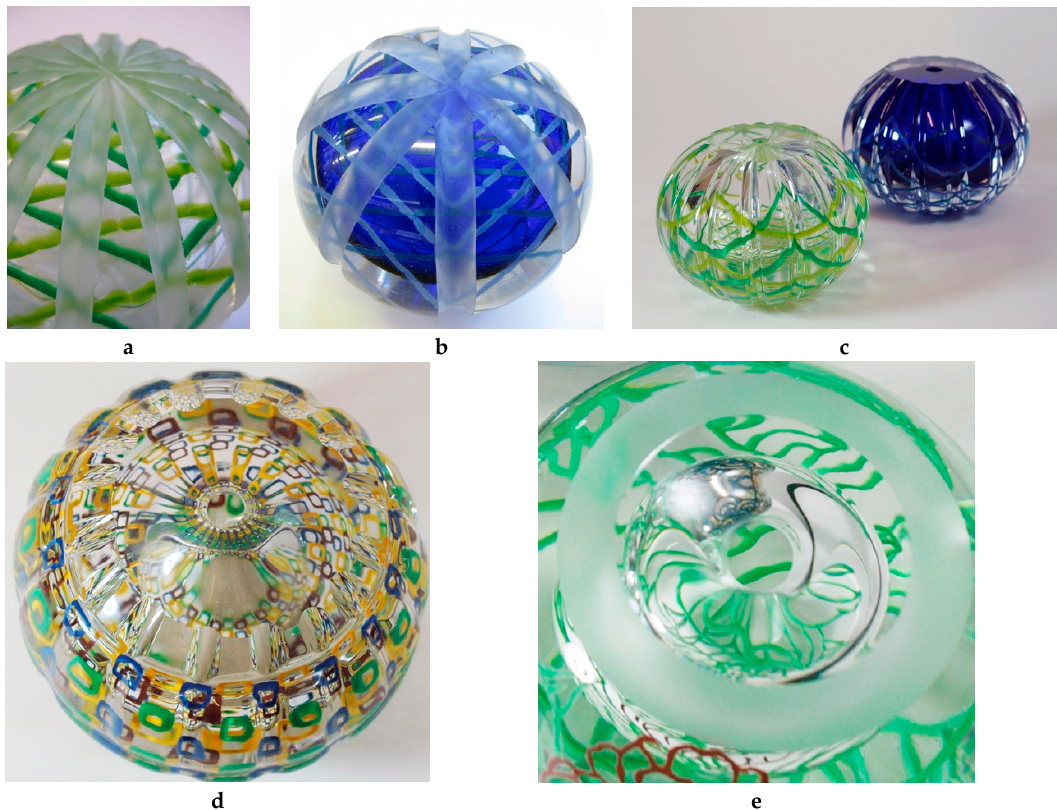
Figure 17. ( a – c ) ‘ Ribbed cut glass ’ tests 1 and 2 (2012). Cristalica glass body with Kugler glass powder: opaque green (K2070-Opal green), (K2076-Opal light green) and opaque blue (K2091-Lapis blue) (K2028-Opal sky blue). ( d ) Flat cut. ( e ) Punty cut (or concave cut).